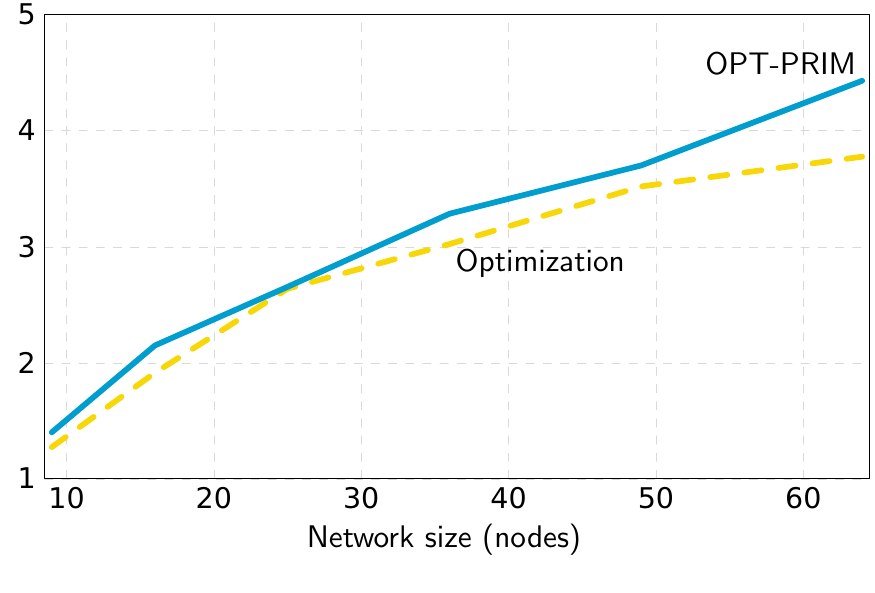
Figure 8. Minimum average number of hops achieved with OPT-PRIM and the optimization